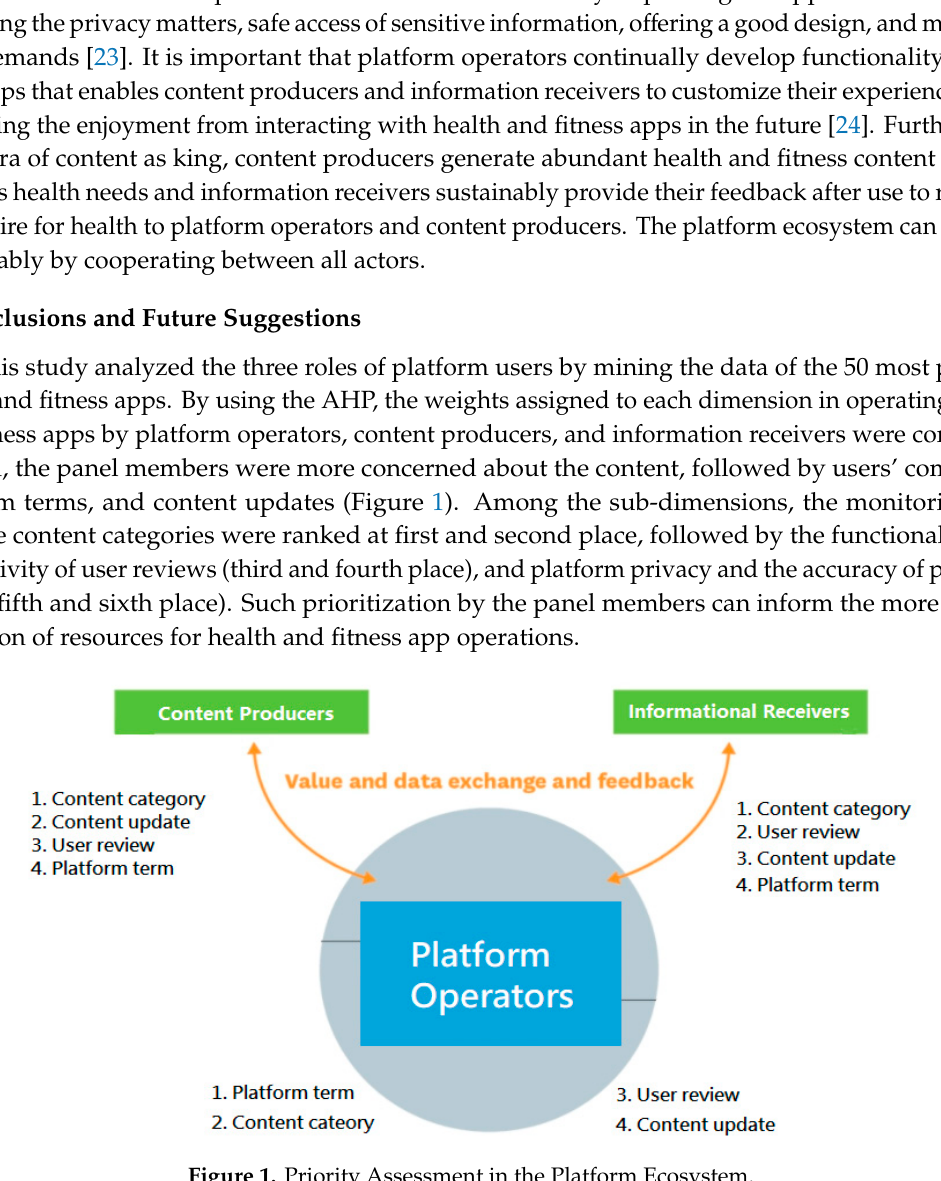
Figure 1. Priority Assessment in the Platform Ecosystem.